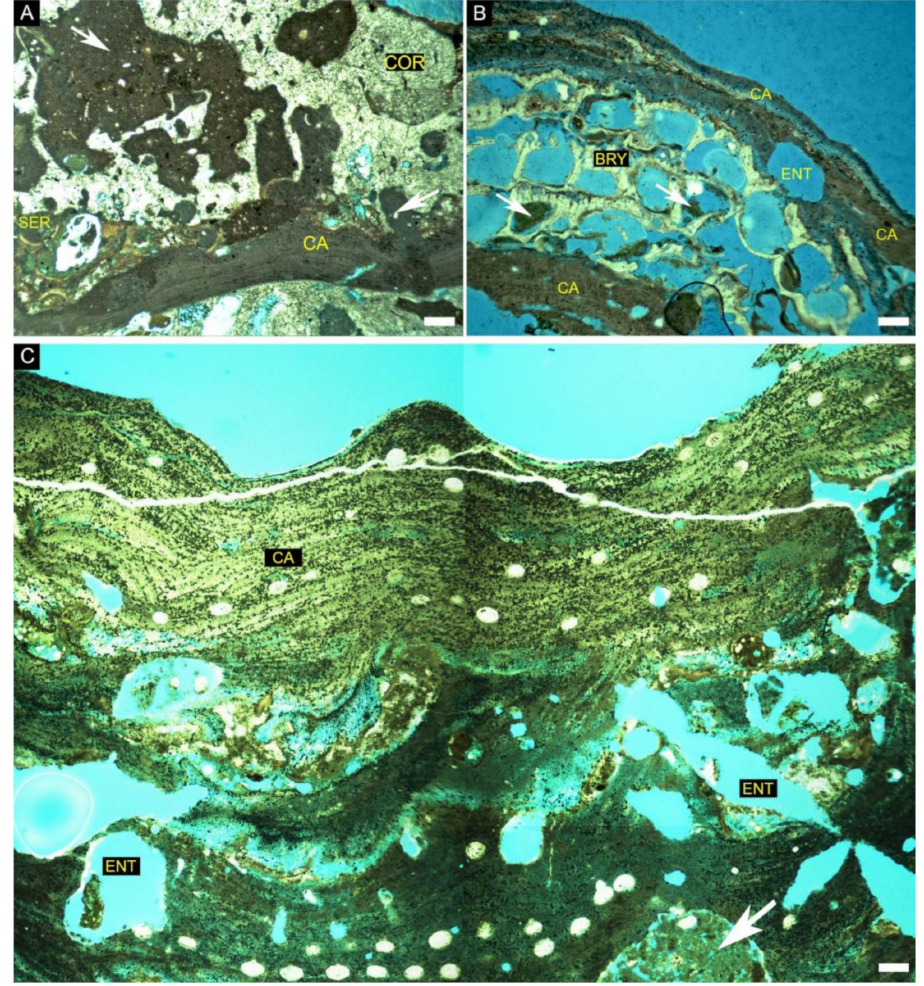
Figure 6. Thin-section images of rhodoliths from site 1 of the north sector of the SEAL Basin (30 m depth). ( A ) Innermost portion of rhodolith sample 1 composed of coral (COR), coralline algae (CA) and serpulid (SER) with borings filled by micrite (white arrow) and siliciclastic grains (quartz-white grains); ( B ) Outermost portion of rhodolith sample 2 composed mainly by coralline algae (CA) intergrown with bryozoans (BRY) with sponge borings ( Entobia -ENT), some filled by packstone (white arrow); ( C ) Middle to outermost portion of rhodolith sample 3 with dominance of Harveylithon gr. catarinense (CA) and sponge borings ( Entobia -ENT), some filled by packstone (white arrow). Scale bars = 200 µ